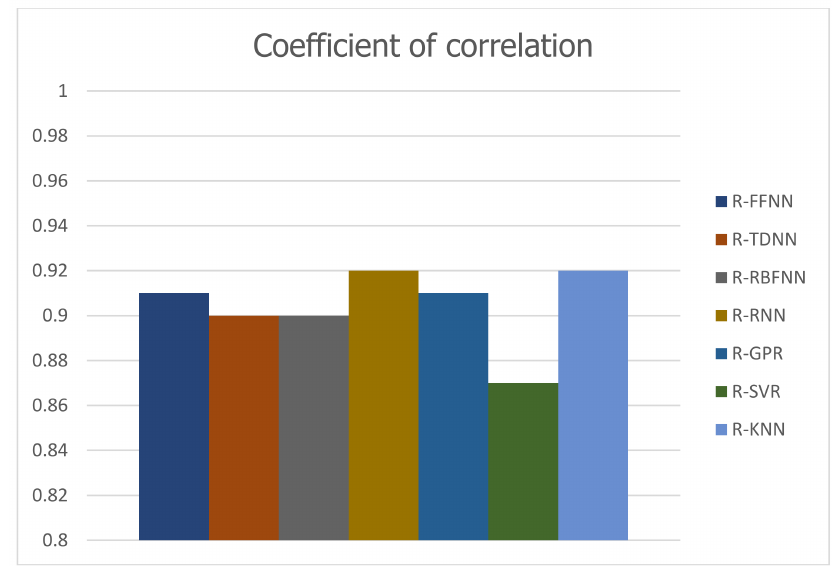
Figure 7. Bar histogram of the correlation coefficient (R) values derived from various